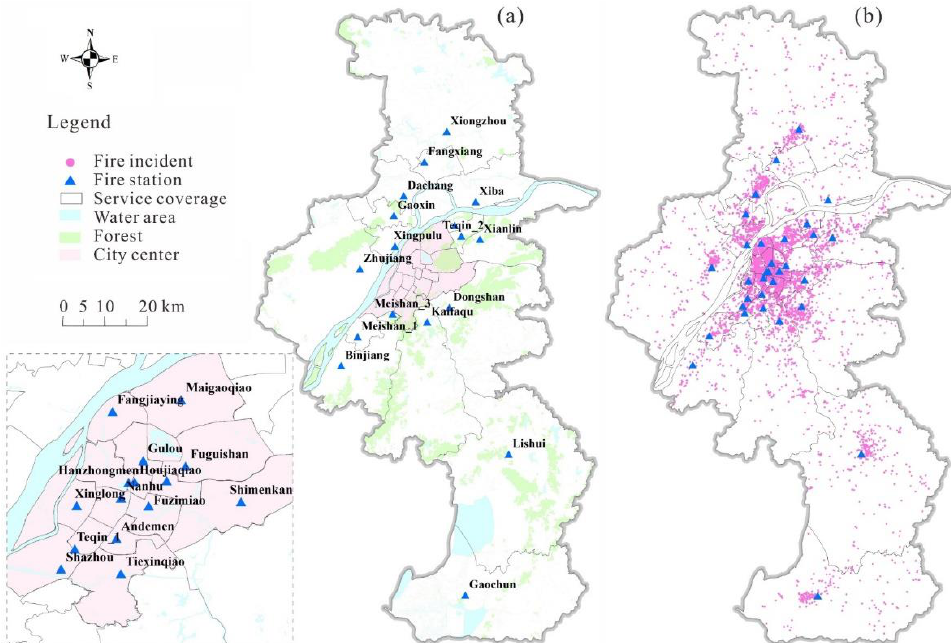
Figure 1. Study area and data in Nanjing, China: ( a ) the service coverage of fire stations; ( b ) historical fire incidents in 2015.